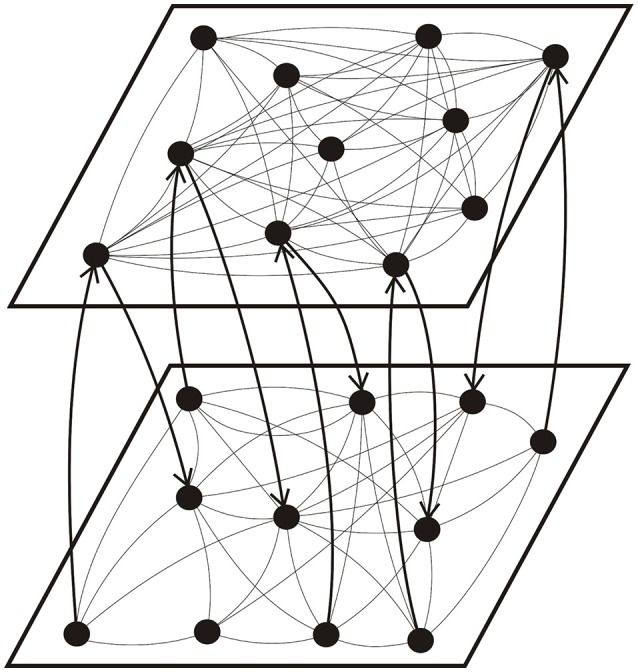
Schematic illustration of the topology of a coupled network consisting of a high connectivity layer (top) and a low connectivity layer (bottom). The arrows show the direction of inter-layer synaptic connections.